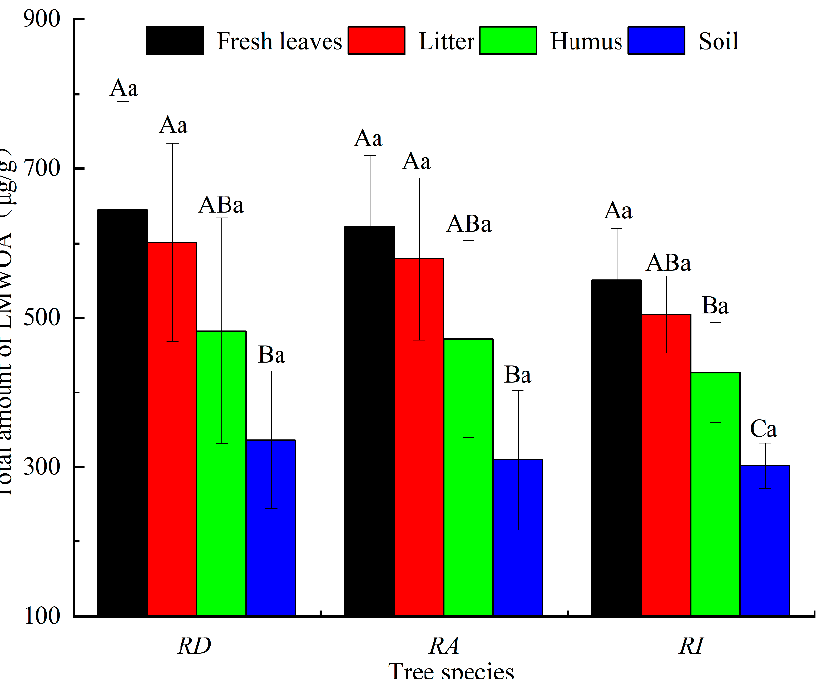
Figure 5. The total LMWOAs’ content in the different rhododendron forests. Note: Different capital letters represent significant content differences between different sampling positions of the same rhododendron ( p < 0.05); different lowercase letters indicate that the LMWOAs’ content between the same sampling position in the different rhododendron forests was significant ( p < 0.05). The values are the mean ± SE.